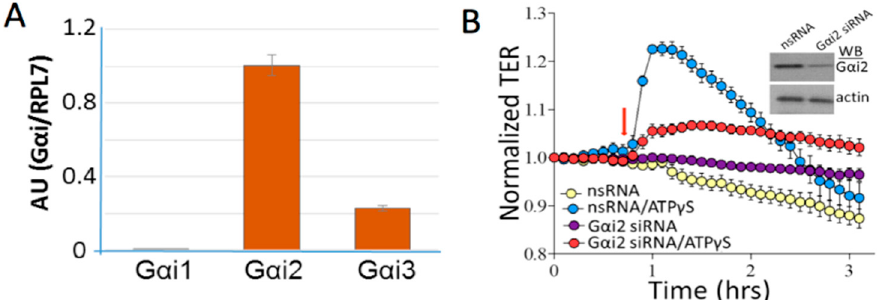
Figure 1. P2Y4 and P2Y12 mediate lung vascular barrier function. ( A ): Quantitative real-time polymerase chain reaction (qPCR) analysis of G α i in lung microvascular endothelial cells; ( B ): depletion of G α i2 attenuated ATP γ S-induced increase of transendothelial electrical resistance (TER). Human lung microvascular endothelial cells (HLMVECs) were transfected with non-specific siRNA (nsRNA) or G α i-specific siRNAs (50 nM, 72 h) and were treated with ATP γ S (100 µ M, arrow). Inset: Western blot analysis shows the efficiency of G α i depletion.